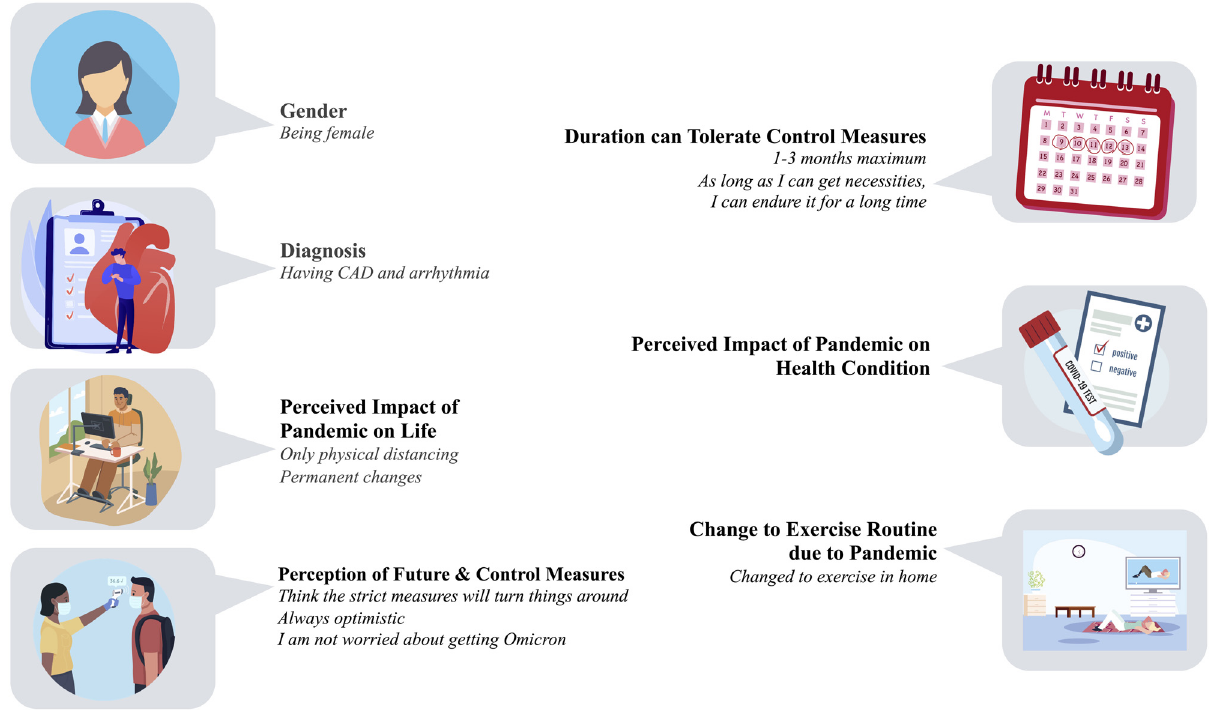
Figure 1: Correlates of psychosocial distress in chronic disease patients during stringent COVID - 19 prevention and control measures. CAD: coronary artery